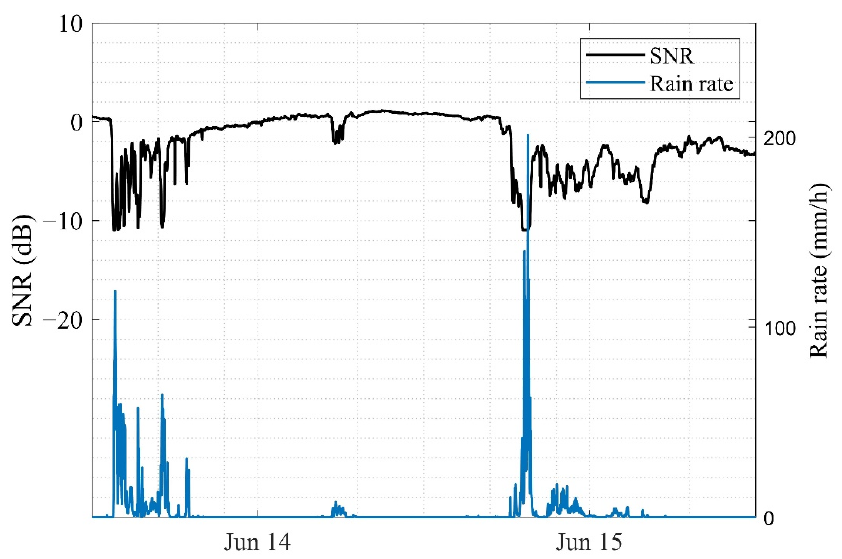
Figure 1. Correspondence between the ESL signal and rainfall from 14 June to 15 June 2020. The black line is the SNR of the ESL signal, and the blue line is the rain rate. black line is the SNR of the ESL signal, and the blue line is the rain